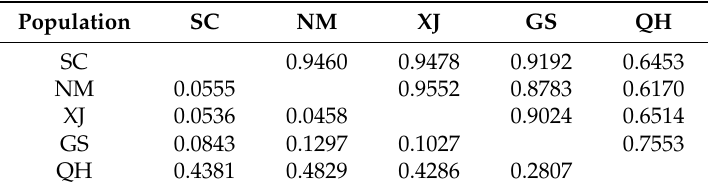
Table 5. Nei’s original measures of genetic identity (above diagonal) and genetic distance (below diagonal) of five geographic regions E. sibiricus